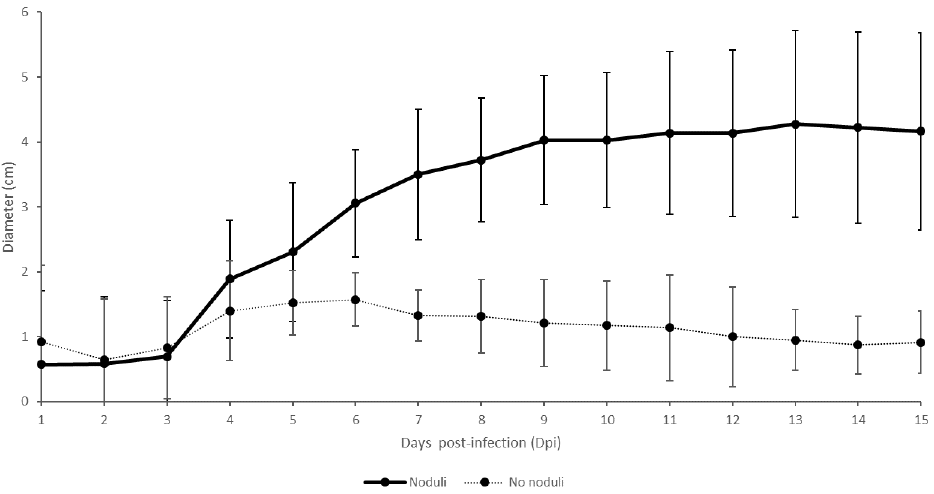
Figure 3. Averaged swellings at the virulent virus inoculation sites (intradermal) on animals with and without skin nodules (in cm). Variation is shown by the error